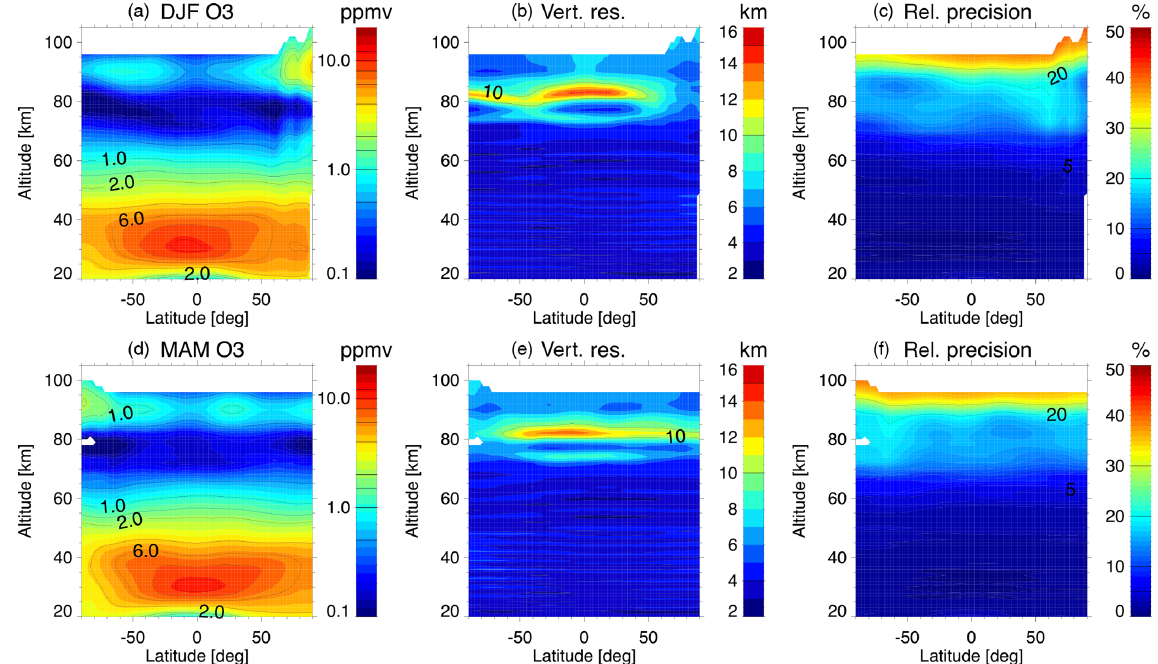
Figure 3. Latitude–altitude cross sections of MIPAS MA daytime ozone (a, d) , its vertical resolution (b, e) , and single profile noise error (1 σ , c, f ) for solstice (December–January–February: DJF) (a–c) and equinox (March–April–May; MAM) (d–f) . All measurements from 2005 to 2012 are included. White areas denote regions where the retrieved O 3 is not significant. Contour lines are marked in the colour bar